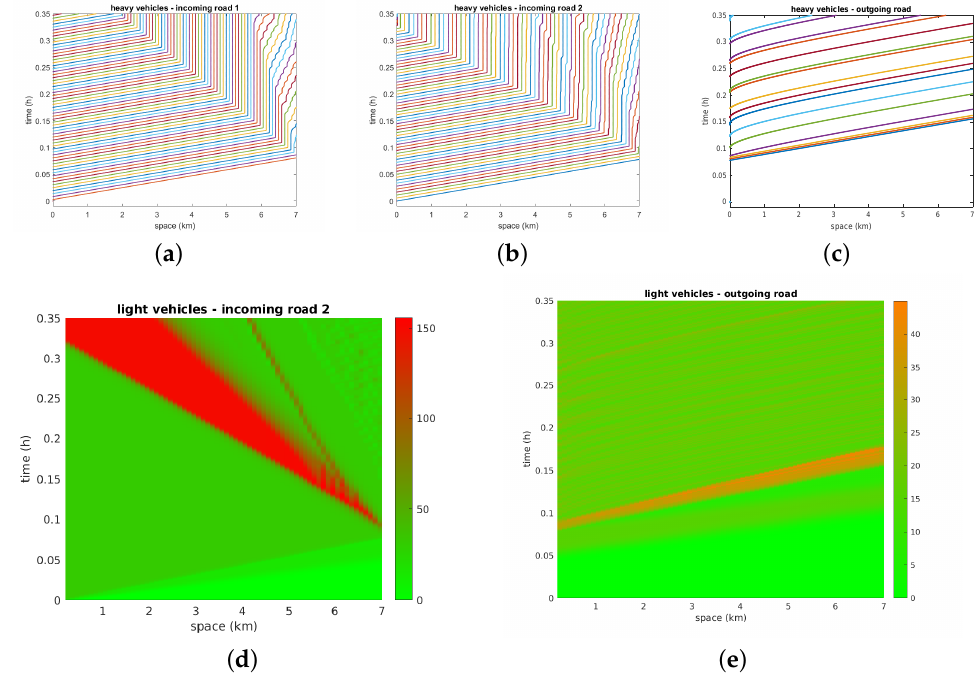
Figure 17. Test 3B: ( a – c ) Trajectories of trucks in space–time on the first incoming road, second incoming road and outgoing road, respectively (for visualization purposes, not all trucks are actually plotted). ( d , e ) Car density on second incoming road and outgoing road,